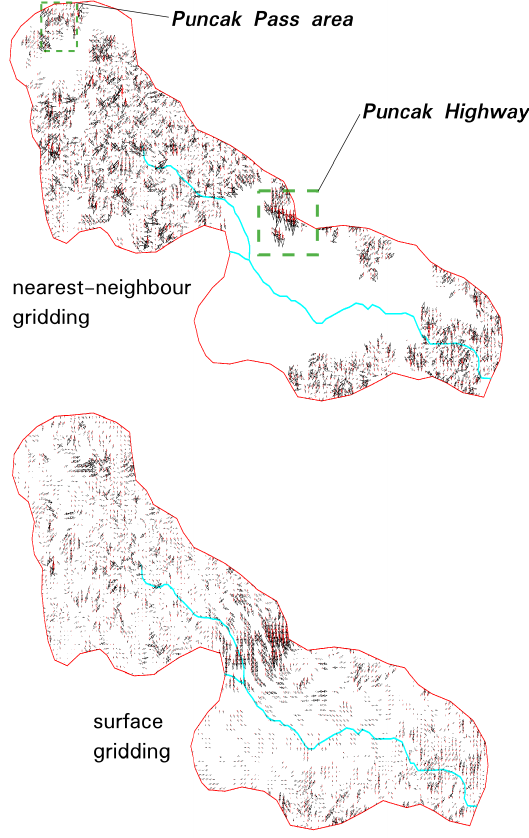
Figure 4. The gridded result from nearest-neighbour (the top image) and surface method (the bottom image). The black arrow represents the horizontal component and the red one for vertical component. The cyan lines illustrates the Cijember